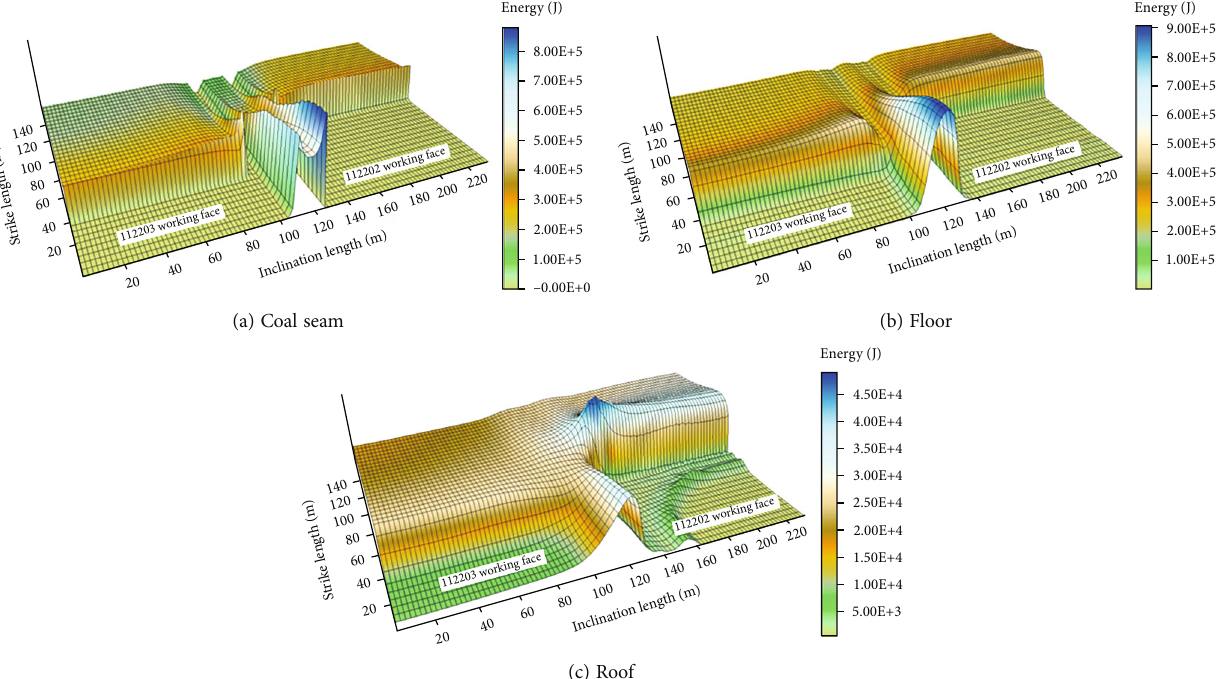
Figure 7: Energy distribution characteristics of the surrounding rock during secondary mining.